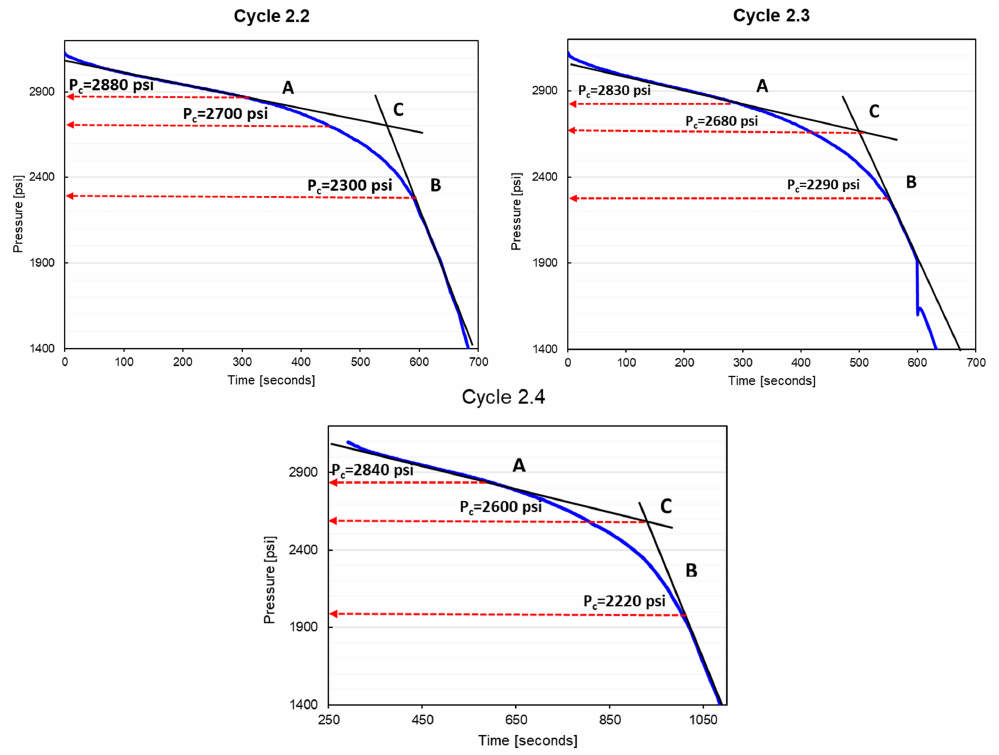
Figure 26. Test 8 cycles 2.2, 2.4, and 2.4 pressure versus time plots indicate three techniques for determining fracture closure. Point ( A ) closure, according to Nolte and Smith [27], point ( B ) closure, according to Shlyapobersky et al. [29]. ( A , B ) closure upper and lower bounds according to Soliman and Daneshy [32], and point ( C ) closure according to Plan et al.